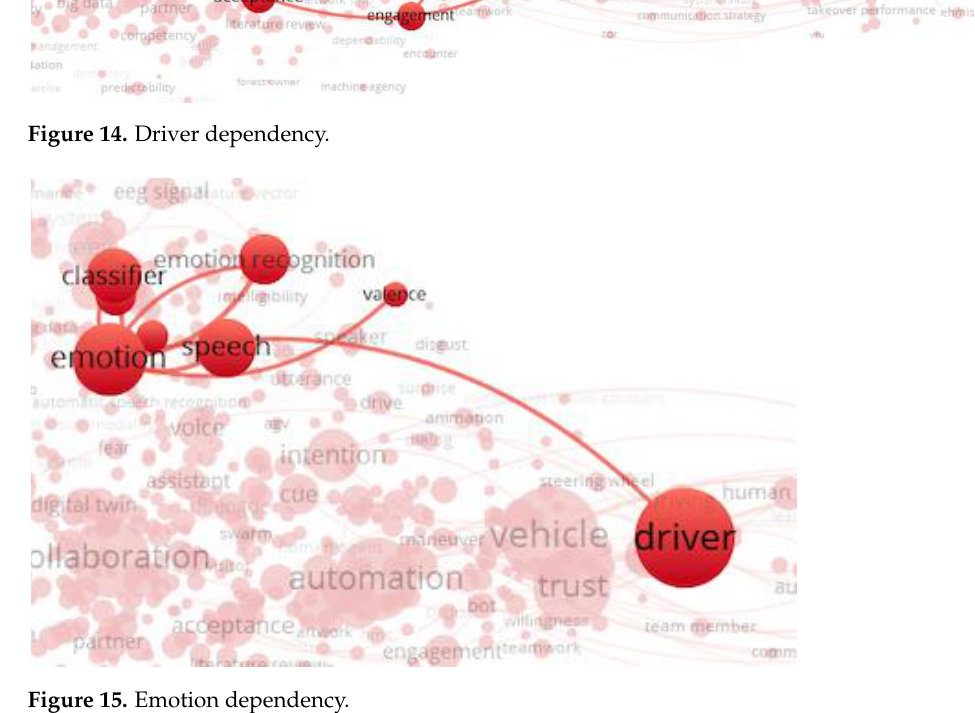
Figure 15. Emotion dependency.